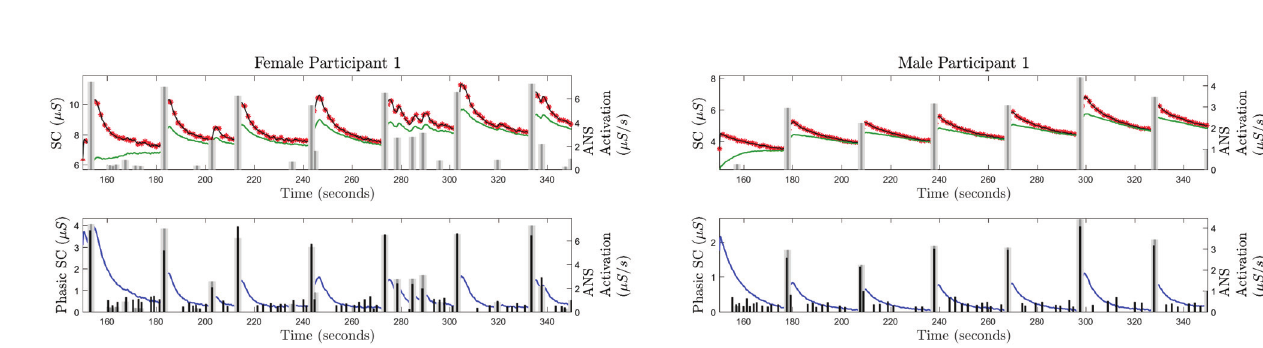
Fig 5. Deconvolution results from the simulated SC signals with 25 dB SNR for one female participant and one male participant. In each of the panels, i) the top sub-panel shows the ground truth for SC signal (red stars), the reconstructed SC signal (black solid curve), the estimated tonic component (green solid curve), and ground truth for the ANS activation (gray vertical lines); ii) the bottom sub-panel shows the estimated phasic component (blue solid curve), estimated ANS activation timings and amplitudes (black vertical lines) and the ground truth ANS activation (gray vertical